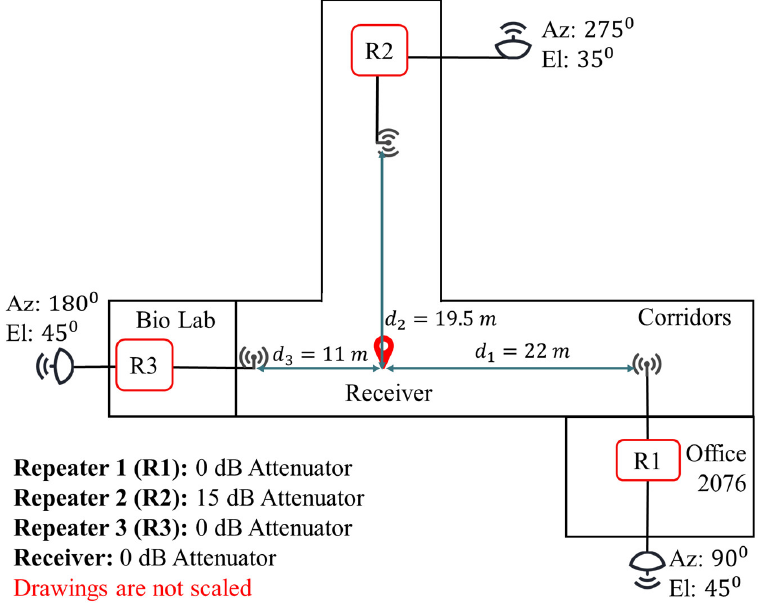
Figure 10. Distance between the receiver and each repeater, directional GPS antenna azimuth (Az) and elevation (El), and the attenuator value in each repeater in Experiment